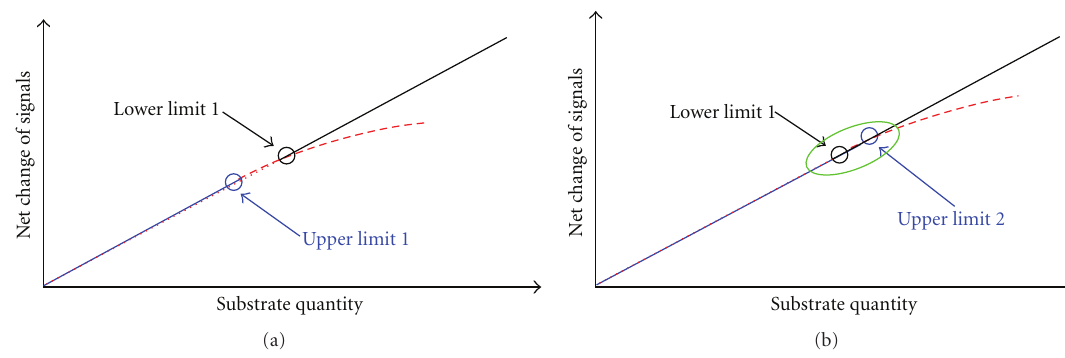
Figure 2: Optimization of activities of a tool enzyme to increase upper limit 1 to upper limit 2 by the equilibrium method for meeting the second prerequisite for an integration strategy to quantify a